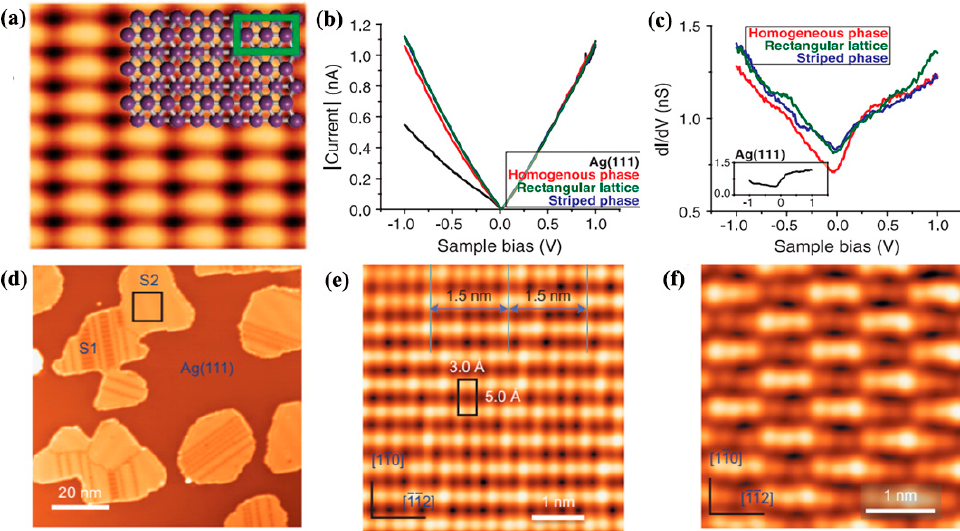
Figure 5. ( a ) Theoretical model and experimental STM images of borophene (V sample = 0.1 V, I tunnel = 1.0 nA). ( b , c ) I–V curves and dI/dV spectra of borophene [24]. Copyright 2015, Science. ( d ) STM image of boron sheets after 650 K annealing, in which two different phases are respectively labeled ‘S1’ and ‘S2’. ( e ) The S1 unit cell and the 1.5-nm stripes are respectively marked by a black rectangle and the solid lines. ( f ) High-resolution STM images of the S2 phase. Bias voltages of STM images: − 4.0 V ( d ), 1.0 V ( e , f ) [25]. Copyright 2016, Springer Nature.